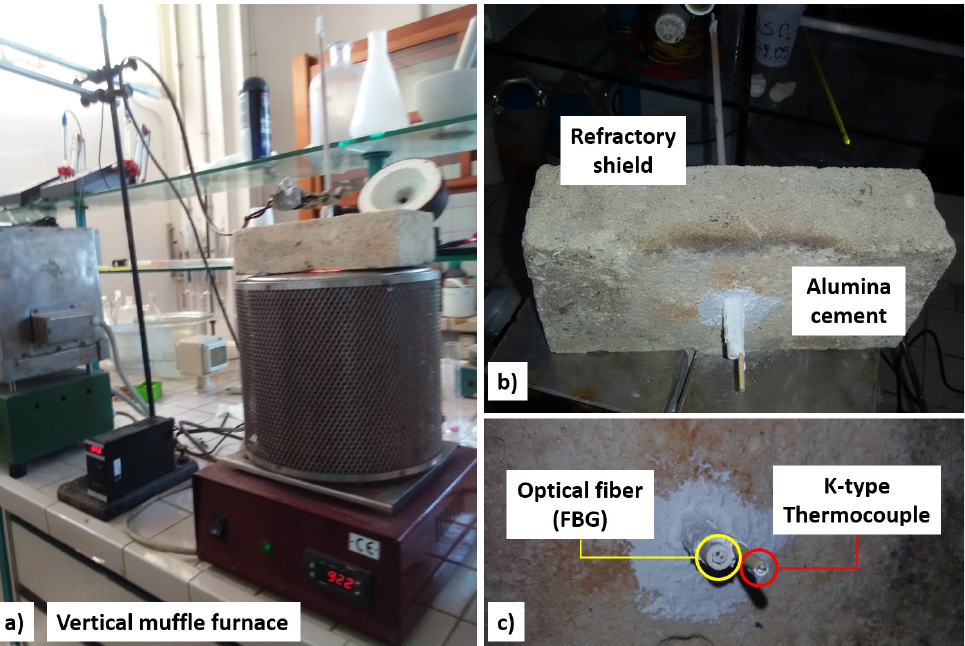
Figure 3. ( a ) Muffle furnace used for high-temperature thermal cycling. ( b ) Refractory feedthrough. ( c ) Detail of the feedthrough consisting of two alumina tubes; the one on the left is a double coaxial tube for passing the fiber optic (FBG), and the one on the right is for passing a K-type thermocouple. The system was sealed with alumina cement.